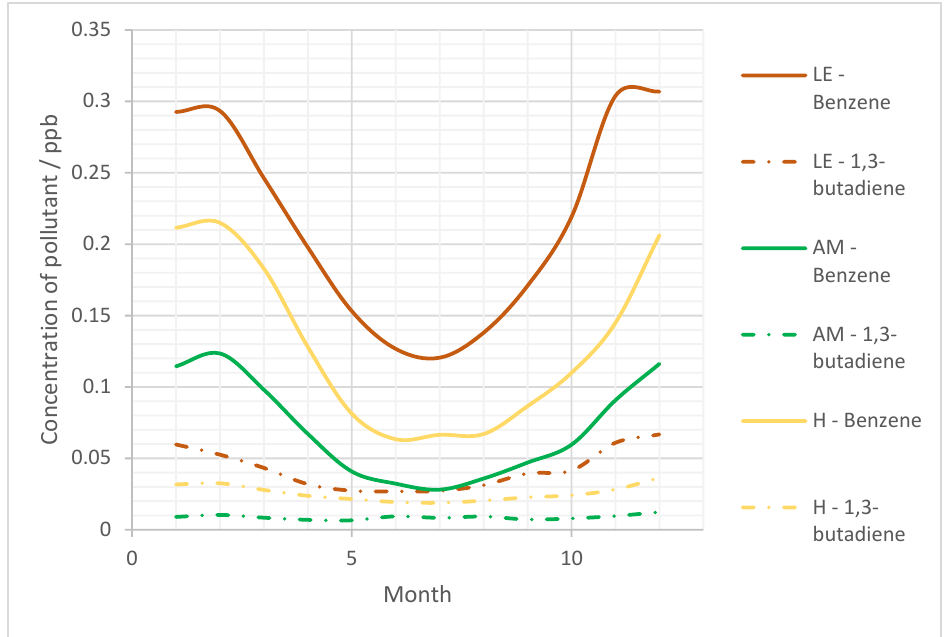
Figure 5. Overall seasonal variation (hourly concentrations averaged across 2000 – 2020) of each pollutant concentration at each of the non-traffic sites LE, AM, and H. LMR excluded from plot due to significantly elevated concentrations in comparison to the sites presented here; same seasonal trend is seen with increased variability due to increased anthropogenic influence.